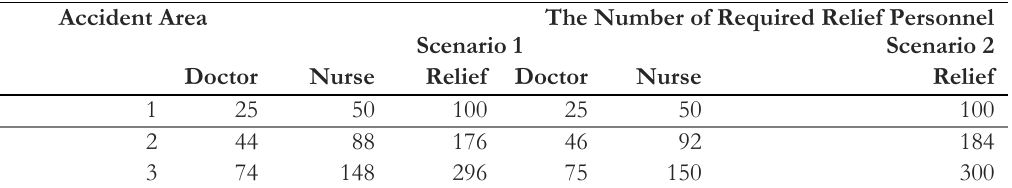
Table 9. The number of required relief personnel in each accident area.